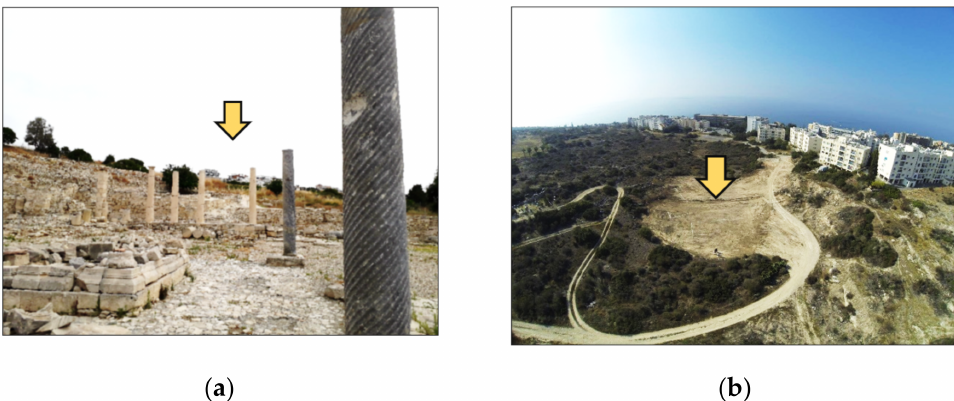
Figure 1. ( a ) New constructions at the eastern part of the Amathus archaeological site indicated with an arrow. ( b ) New areas developed, in the eastern part of the Amathus site, whereas geophysical prospection surveys have been carried out by the Laboratory of Geophysics—Satellite Remote Sensing and Archaeoenvironment, Institute for Mediterranean Studies (IMS), Foundation for Research and Technology Hellas (FORTH) (photos taken in